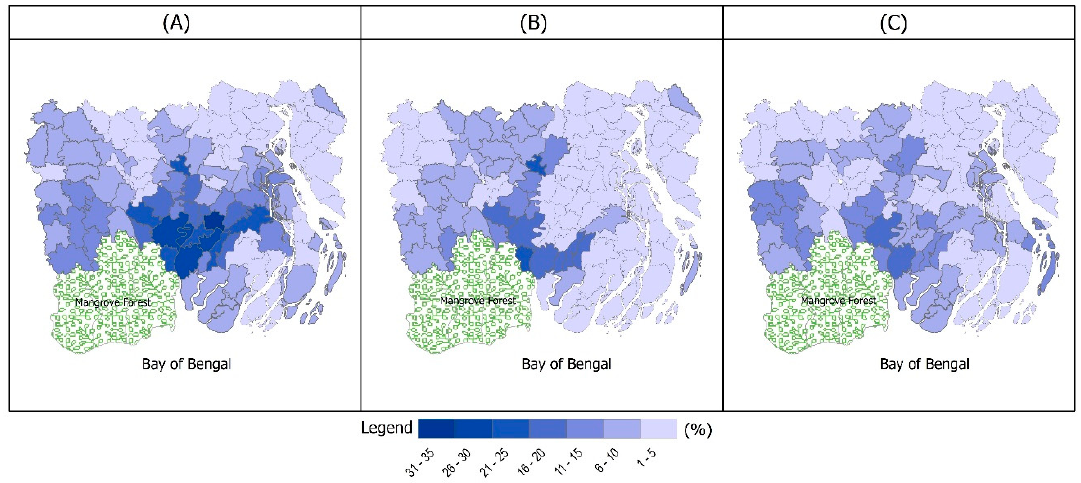
Figure 4. Flooding inundation after cyclone Amphan landfall shown as percentage of flooding inundation, for the sub-district level, Bangladesh. Map ( A ) referes to 22 May, ( B ) 28 May, and ( C ) 7